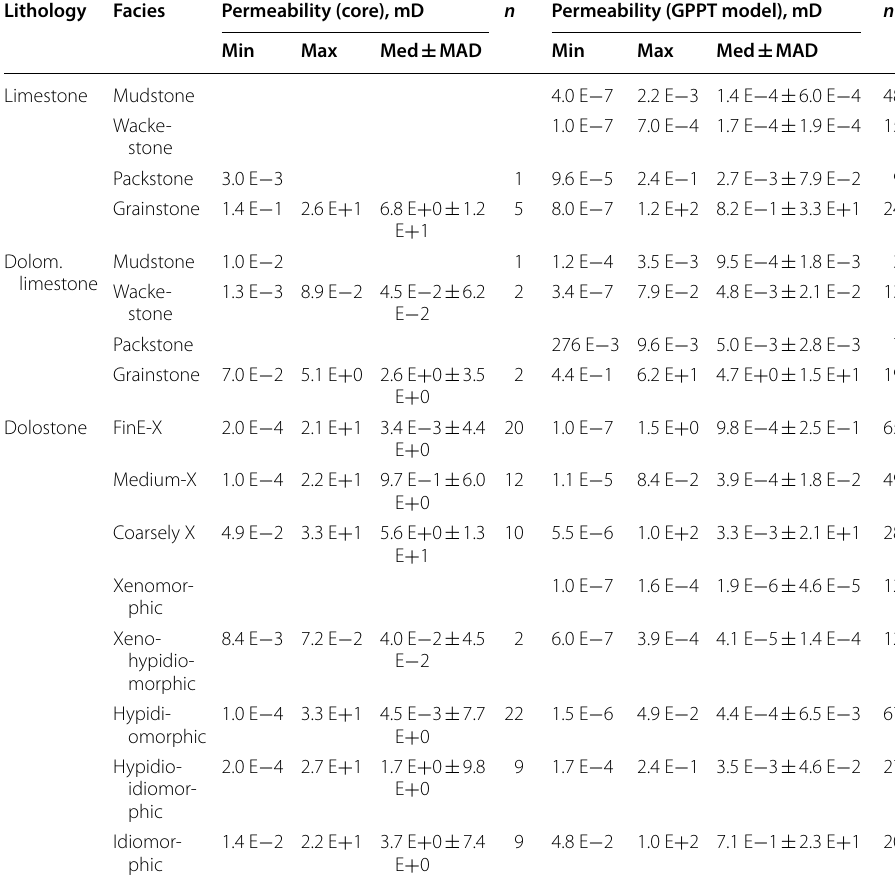
See Table 9. Table 9 Permeability data set for MSC-4 and DGF-FB grouped by facies, crystal size and crystal morphology